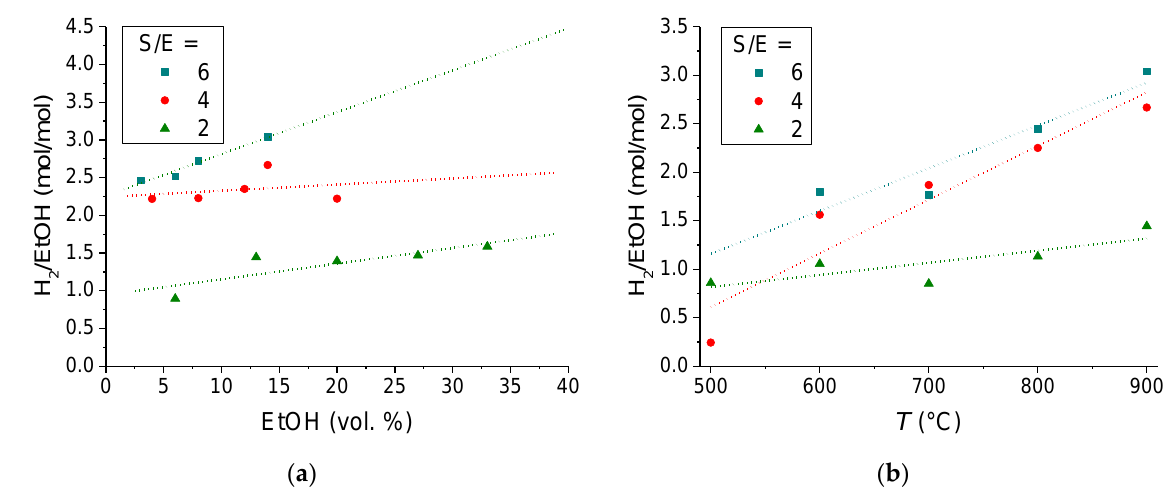
Figure 9. Effect of fuel concentration in Ar ( a ) at T = 900 °C and an operating temperature ( b ) on the amount of hydrogen produced from 1 mol of ethanol at the S/E = 6,4,2. ( b ) Data for the fuel concentration in vol.%: 14 (S/E = 6), 16 (S/E = 4), 13 (S/E = 2).